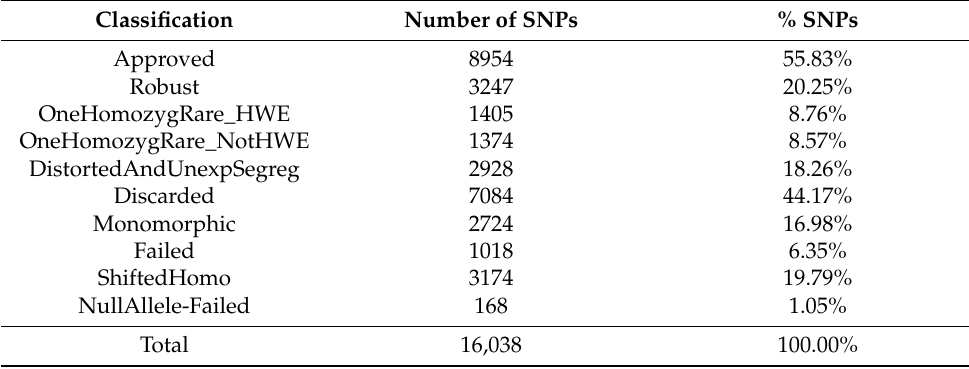
Table 1. Classification of Single Nucleotide Polymorphisms (SNPs) using